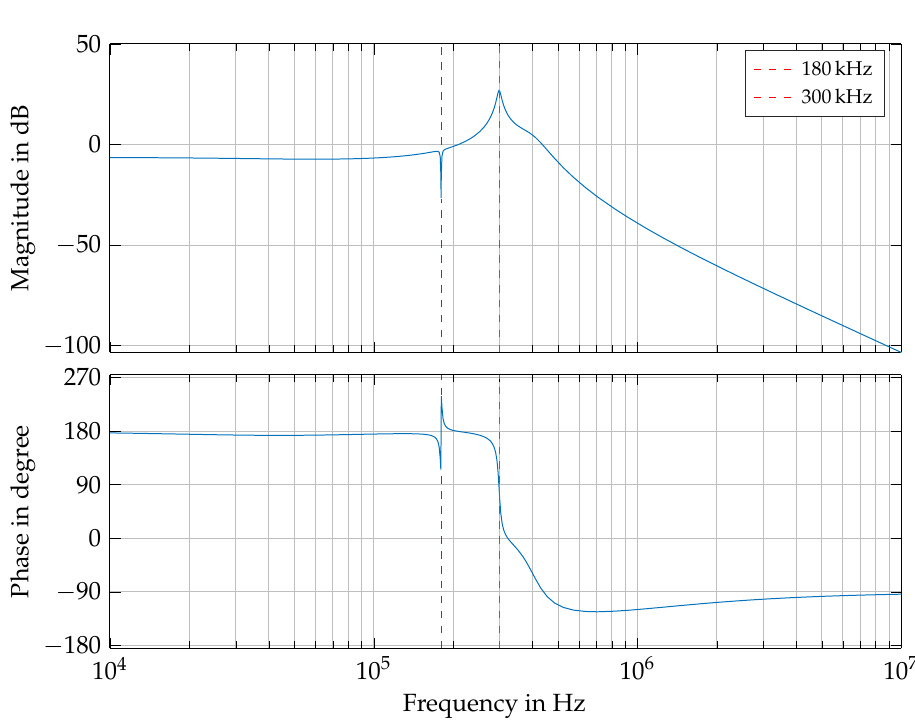
Figure 7. Bode plot of the transfer function G B ( s )